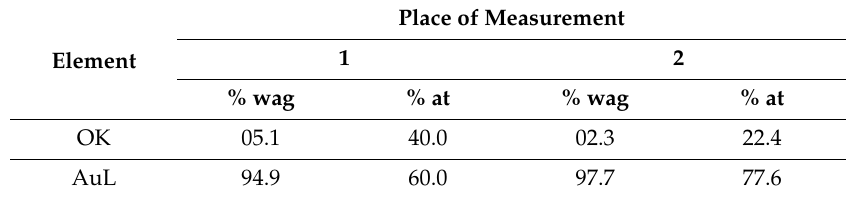
Table2. ResultsofthequantitativemicroanalysisofthechemicalcompositionoftheAuelectrodesurface.